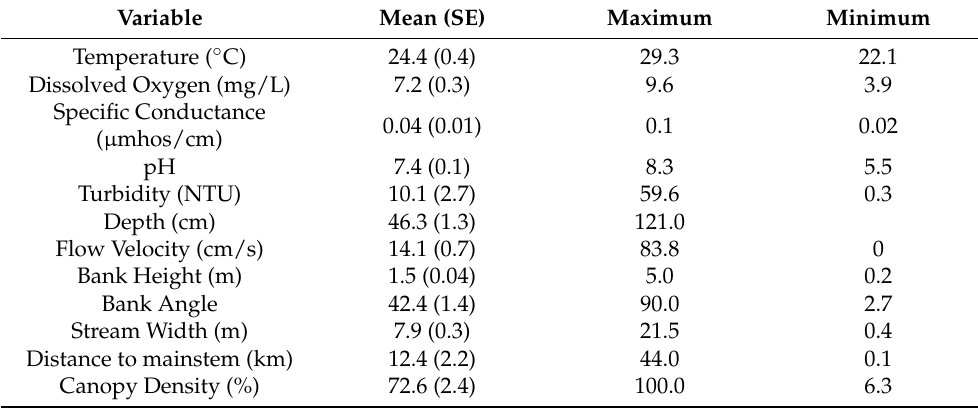
Table 2. Maximum, minimum, and mean (standard error; SE) values for measured physical and water quality variables in Pearl River tributary streams during 2015 and